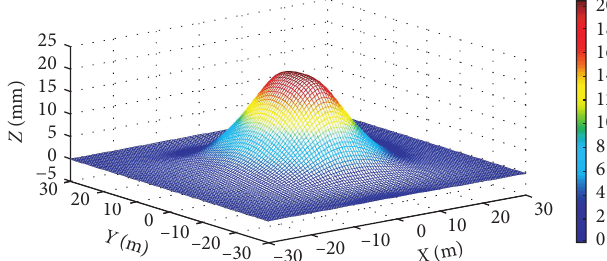
Figure 12: Heaving displacement of the ground surface caused by freezing for 60 days (mm, α � 0 ° ).